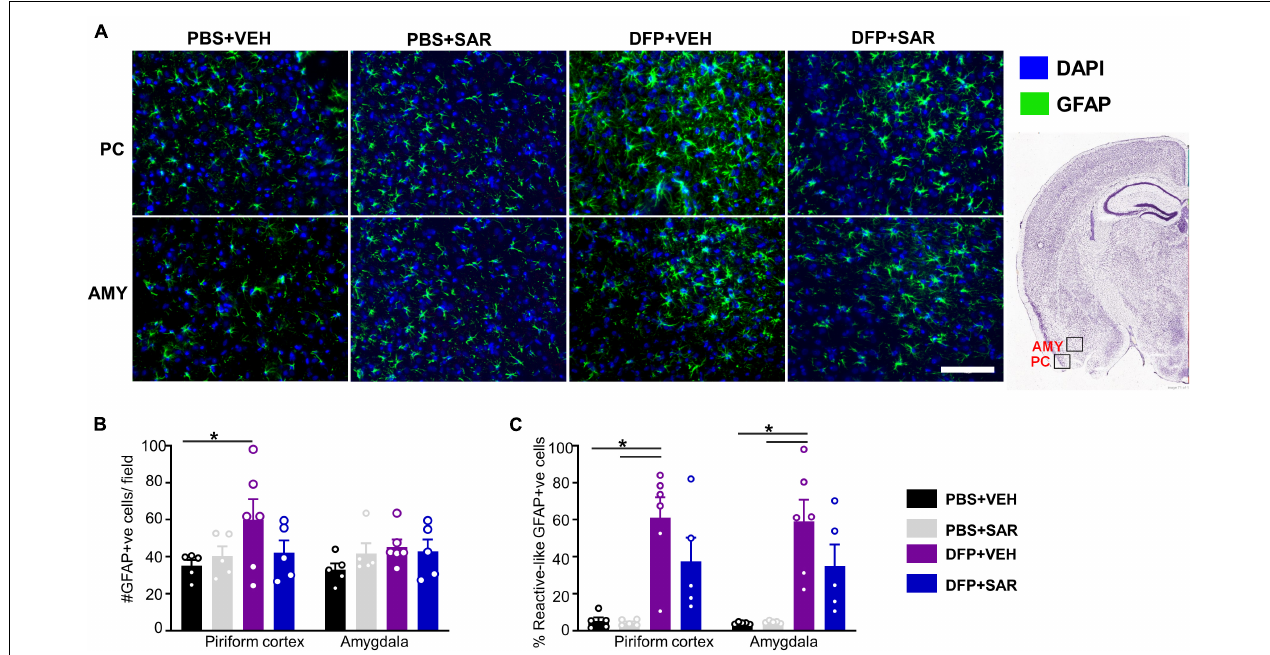
FIGURE 9 | Effects of SAR on DFP-induced astrogliosis. (A) Representative images of GFAP positive images from the piriform cortex (PC) and amygdala (AMY). (B,C) DFP led to a significant upregulation of GFAP positive cells (B) and GFAP positive cells with reactive (A1) like morphology (C) with significant modulation by SAR in the AMY, however; the difference in the PC was not significant (mixed measures ANOVA, ( n = 5-6). GFAP = glial fibrillary acidic protein, DAPI = 4 (cid:48) ,6-diamidino-2-phenylindole. Error bars indicate standard error of the mean. Mixed measures ANOVA, n = 5-6. * p < 0.05. Area counted = 0.14 mm 2 Atlas Image credit: Allen Institute, United